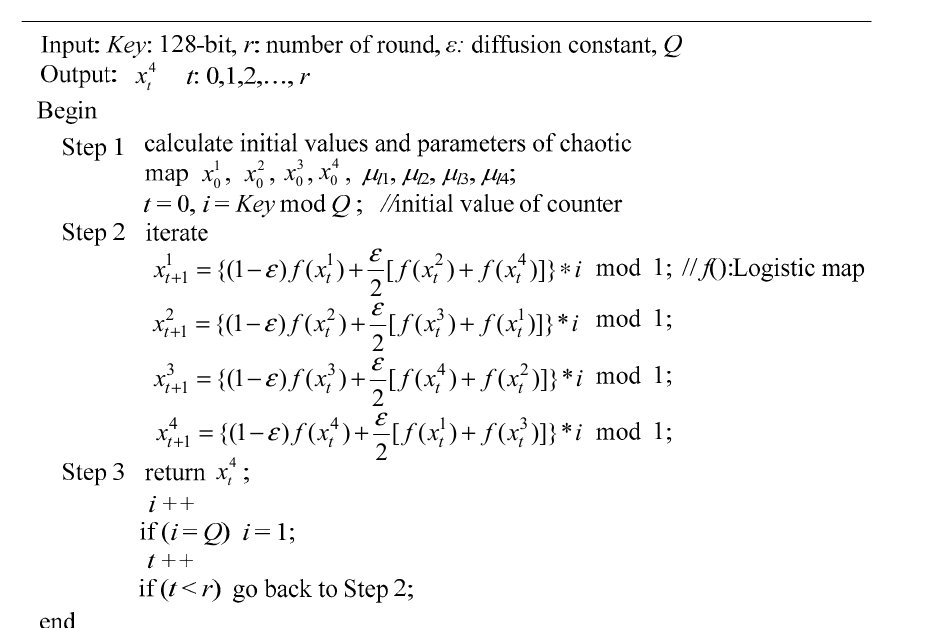
Figure 7. The structures of the improved four stage CML based on the logistic map.